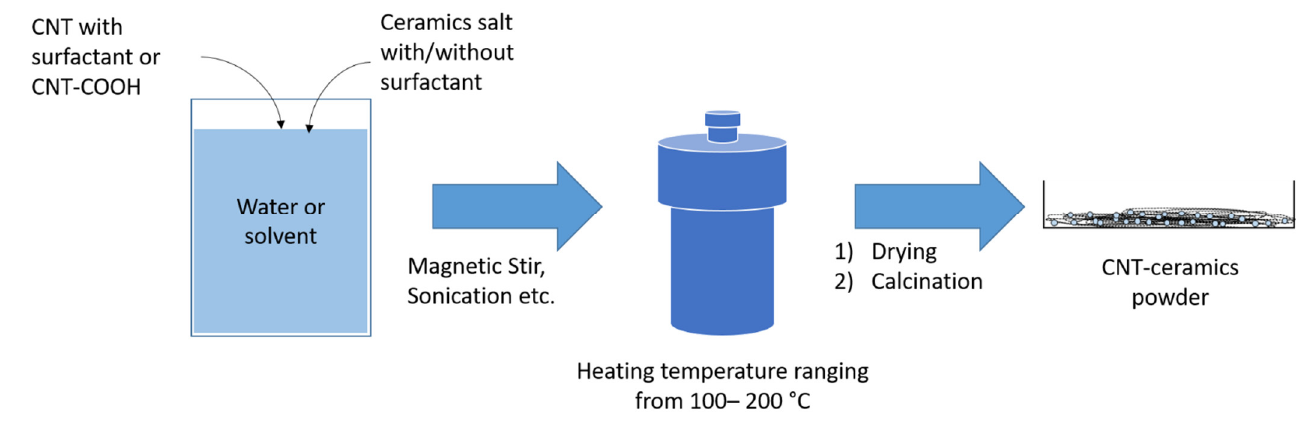
Figure 9. Hydrothermal (or solvothermal) processing scheme of CNTs-CMCs.